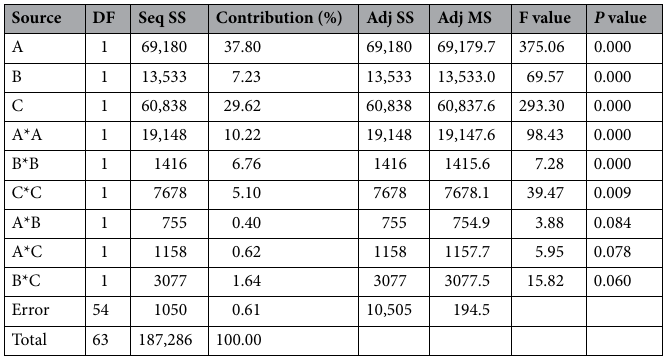
Table 9. ANOVA on compressive strength (CS).